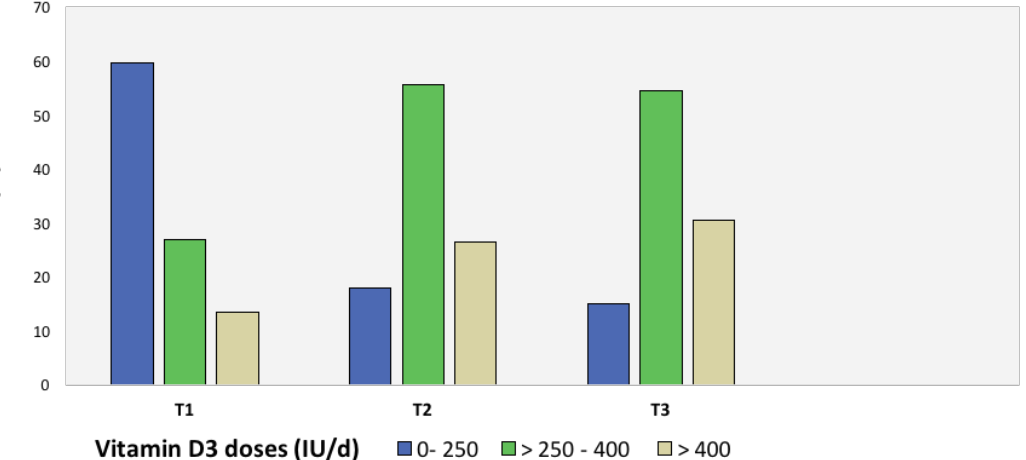
Figure 1. Doses of vitamin D3 supplementation during pregnancy in studied women.